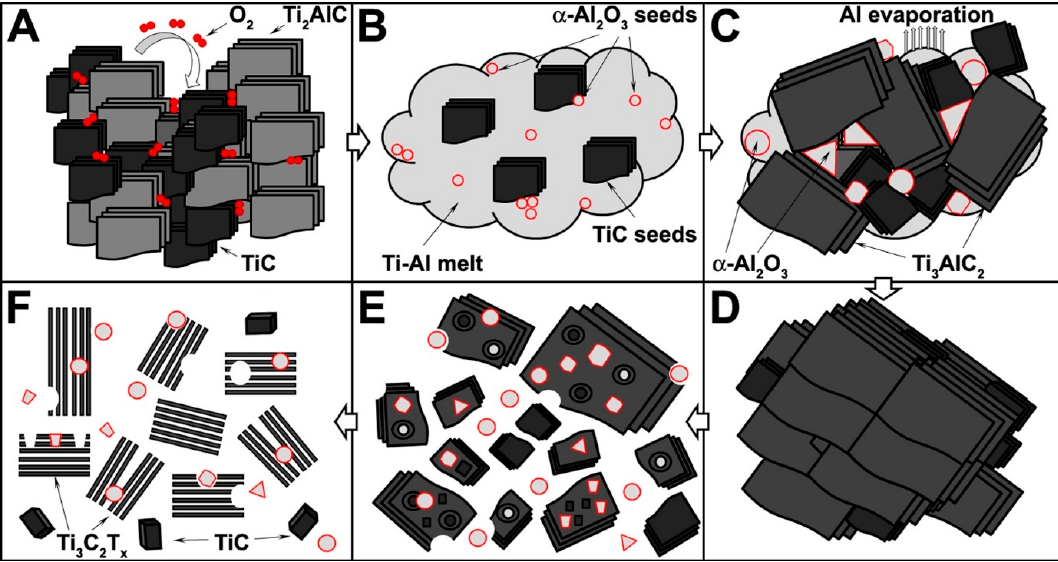
Figure 5. The formation of α -Al 2 O 3 microparticles during Ti 3 AlC 2 MAX phase synthesis.